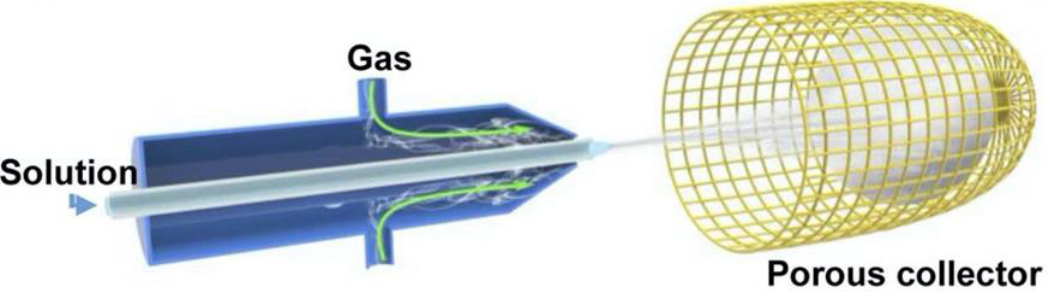
Figure 4. Fabrication process of solution blow spinning (Reprinted with permission from Ref. [6]).